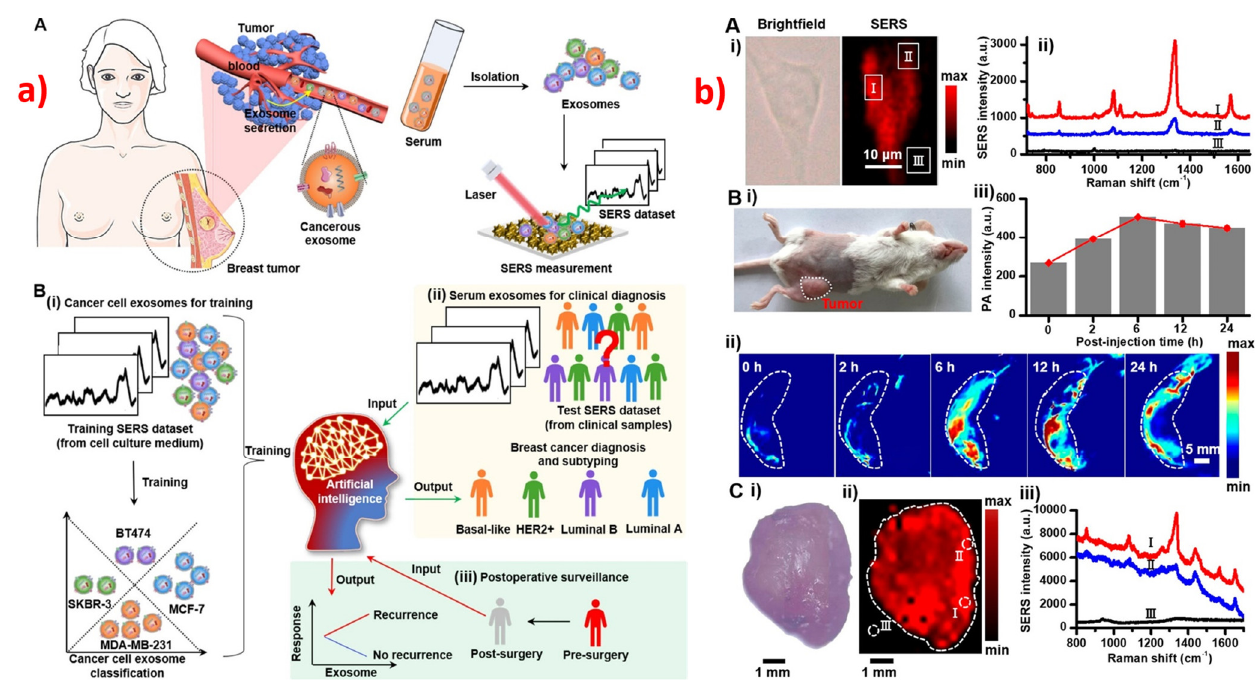
Figure 4. Breast cancer detection using SERS. ( a ) Schematic of workflow for ( A ) sample collection and ( B ) deep learning model-based breast cancer detection with exosomes-based SERS sensor. Re- produced with permission from [143]. Copyright (2022), American Chemical Society. ( b ) SERS and Photoacoustic (PA) imaging of breast cancer cells ( A ): ( i ) brightfield microscopic images and SERS mapping area, and ( ii ) corresponding SERS spectra in different regions labeled in ( i ). ( B ) ( i ) Photo of mouse with tumor, ( ii ) corresponding representative PA images for different post injection times, and ( iii ) PA intensity at 750 nm. ( C ) ( i ) Optical image of tumor, ( ii ) SERS image of tumor, and ( iii ) corresponding spectra for different regions in the image. Reproduced with permission from [144]. Copyright (2021), American Chemical Society.